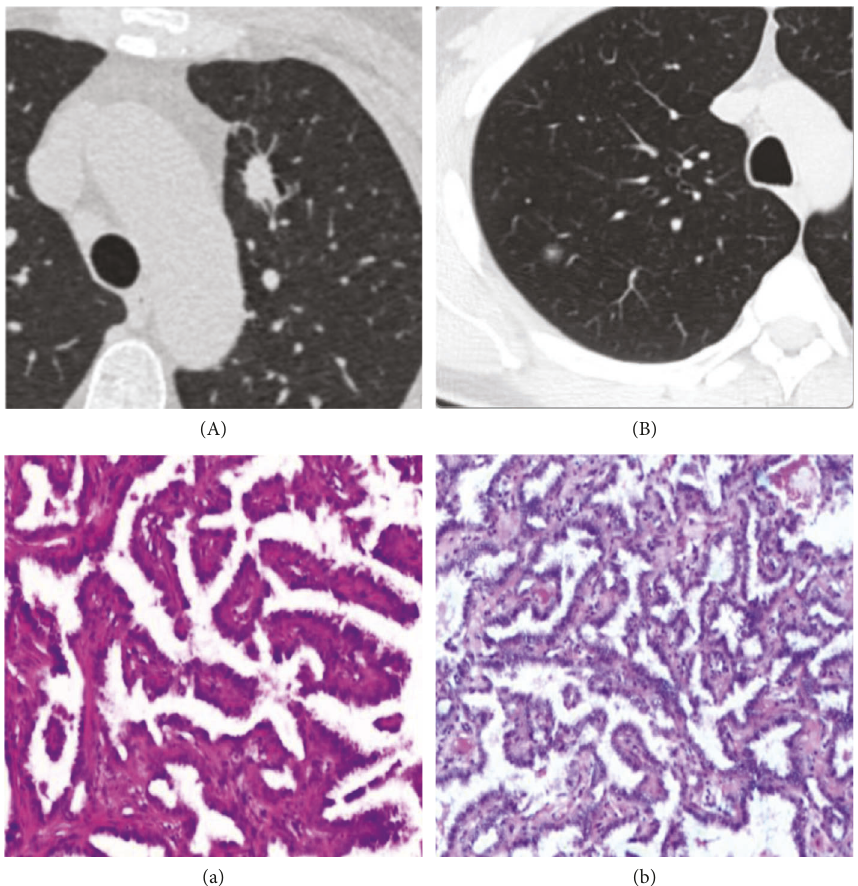
Figure 3: Correlation of nodule margin with the pathological results. Nodules were shown on HRCT with spiculation margin (A) and smooth margin (B), and their corresponding pathological results were ICA (a) and AAH